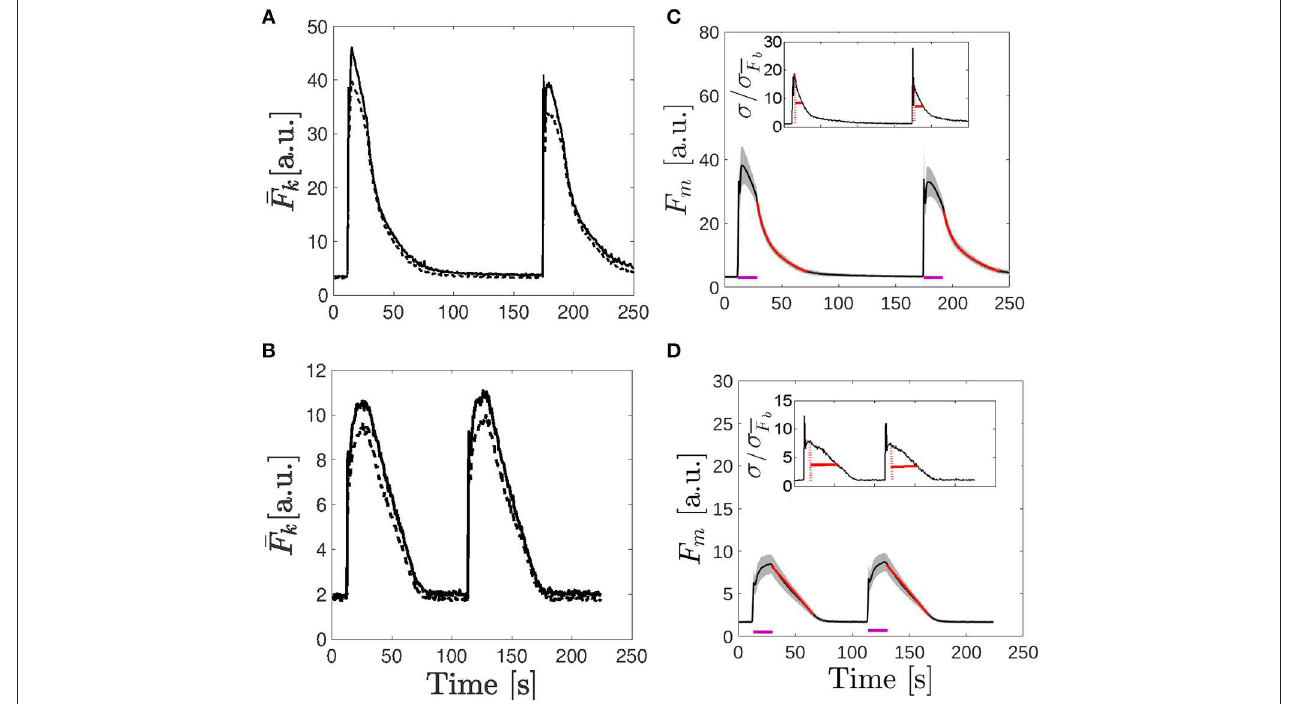
FIGURE 4 | Comparison of the fluorescence time course obtained in the examples of Figures 2 , 3 . (A,B) Time course of the fluorescence, F k , averaged over the two 50 50 pixel subregions depicted in Figure 2F (A) and Figure 3F (B) . In both cases, the solid line corresponds to k × fluorescence, F m given by Equation (1) (black curve), and region around determined by the standard deviation, F m functions of time for the immature oocyte (C) and for the egg (D) . Fits to the traces after the UV flash was turned off are shown in red [bi-exponential fit given by Equation 4 in (C) and linear fit given by Equation 6 in (D) ]. The purple lines indicate the times during which the UV pulses were on. In the insets the ratio, σ F ( t ) /σ F with σ F , the deviation before the first UV flash was delivered, is plotted. The maximum ratio is indicated with a dotted red line and the solid red line indicates the time b it takes for the ratio to fall by